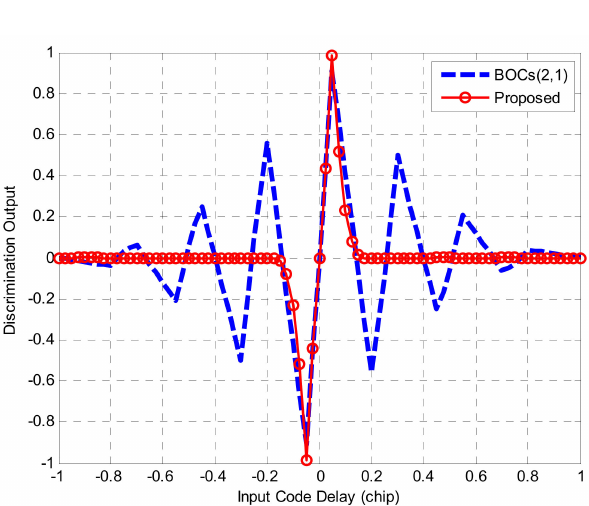
Figure 12. The reconstruction correlation function of the BOCs(2,1) signal. Based on Equation (23), ignoring the noise component in the discriminator output, Figure 10 shows this curve for the correlator spacing d = 2 δ Tc without the front-end filter. In order to clearly show the before and after improvement of the phase detector output, the discriminator curve using the NELP loop for the BOCs(2,1) autocorrelation function